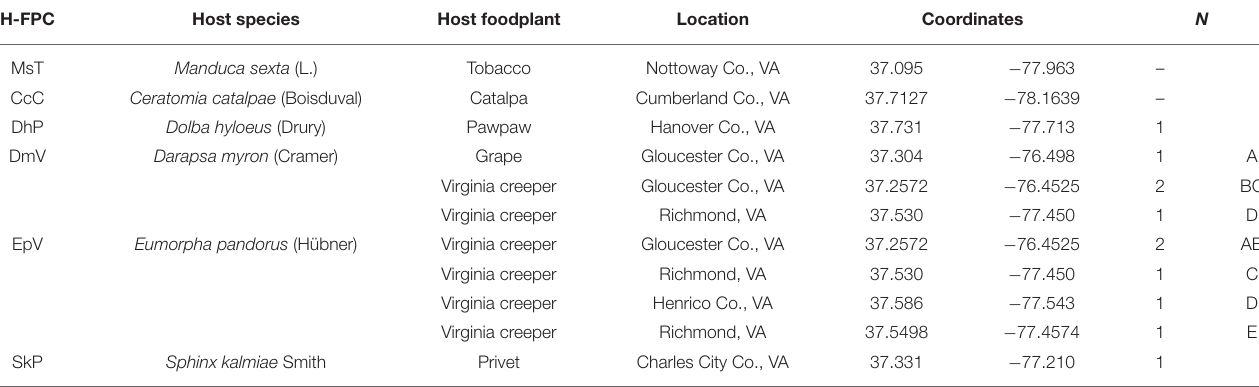
TABLE 1 | Cotesia congregata host-foodplant complex (H-FPC) sources collected and used in this study with lepidopteran host names, foodplant, collection locations (county/city, state), coordinates (lat, long, datum: WGS84), and number and letter designations of wasp broods collected at each site. H-FPC Host species Host foodplant Location